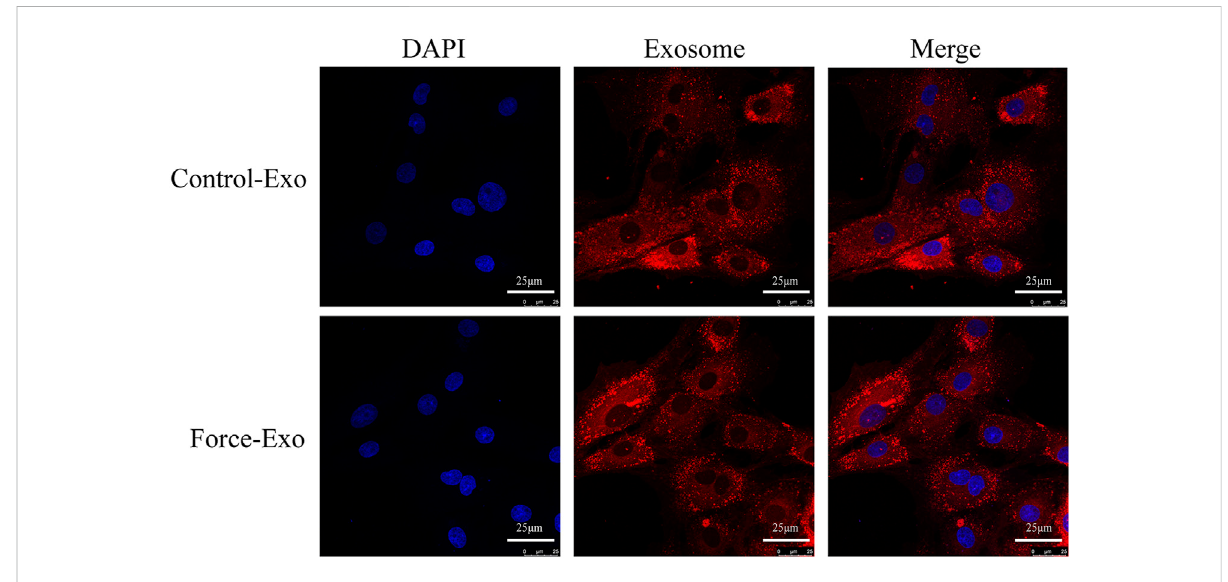
FIGURE 5 Dye-based tracing of exosomal uptake by rat condylar chondrocytes. DAPI-stained nuclei appear blue, and PKH26-stained exosomes appear